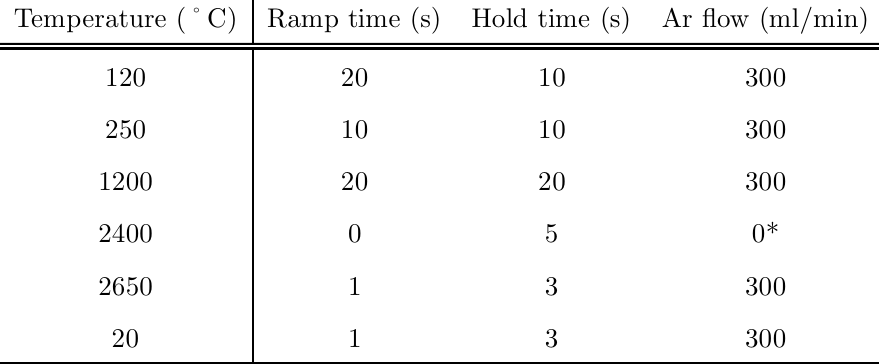
Table 1 Analytical conditions for As and graphite furnace programs. HGA-500 - Dry ashing of samples with Mg(NO 3 ) 2 , wavelength 193.7 nm, spectral bandpass